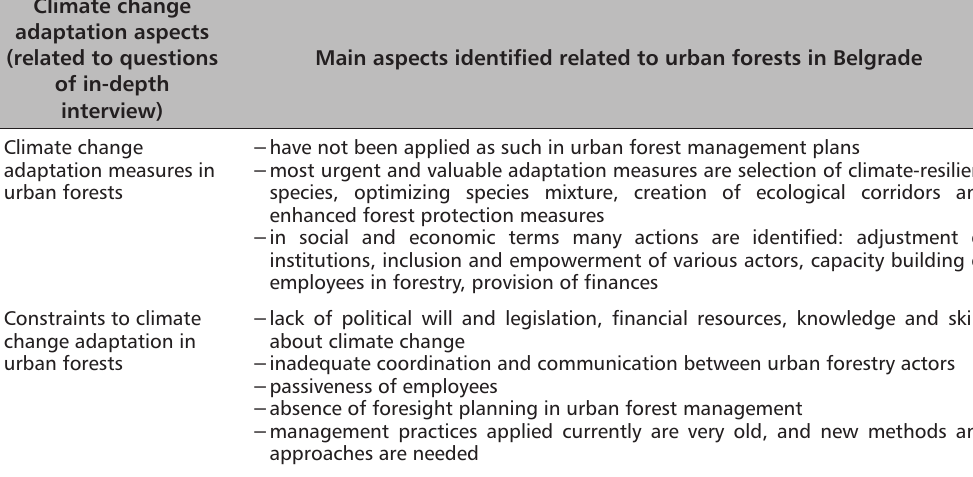
TABLE 3. Summary of main aspects revealed through in-depth interviews -